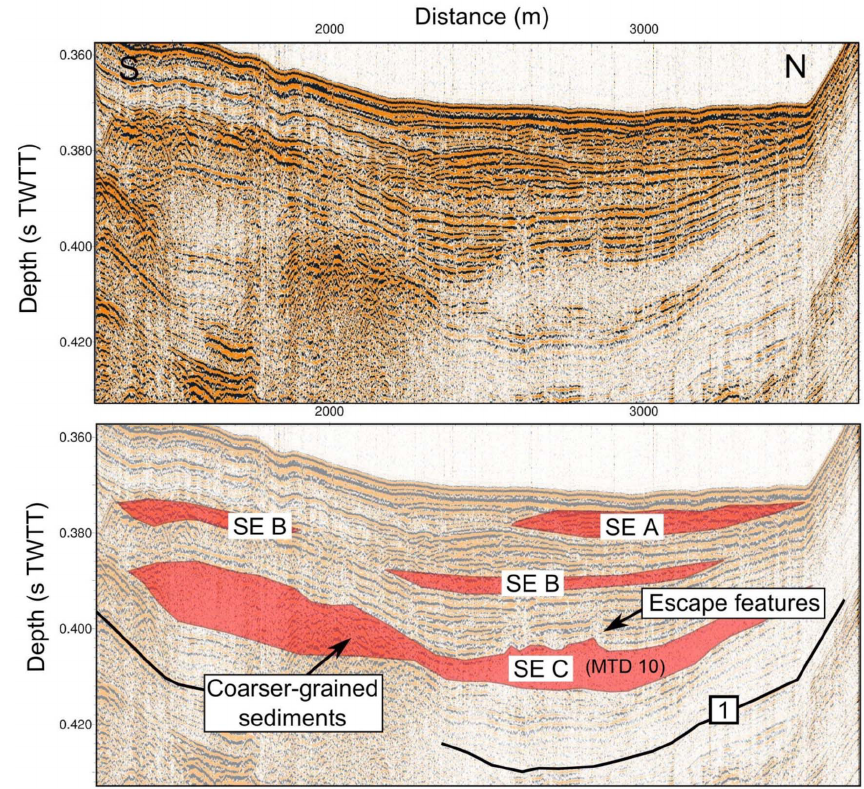
Figure 5. Examples of mass transport deposits in Mornos Canyon basin. See the location of the sparker seismic profile in Fig. 2.